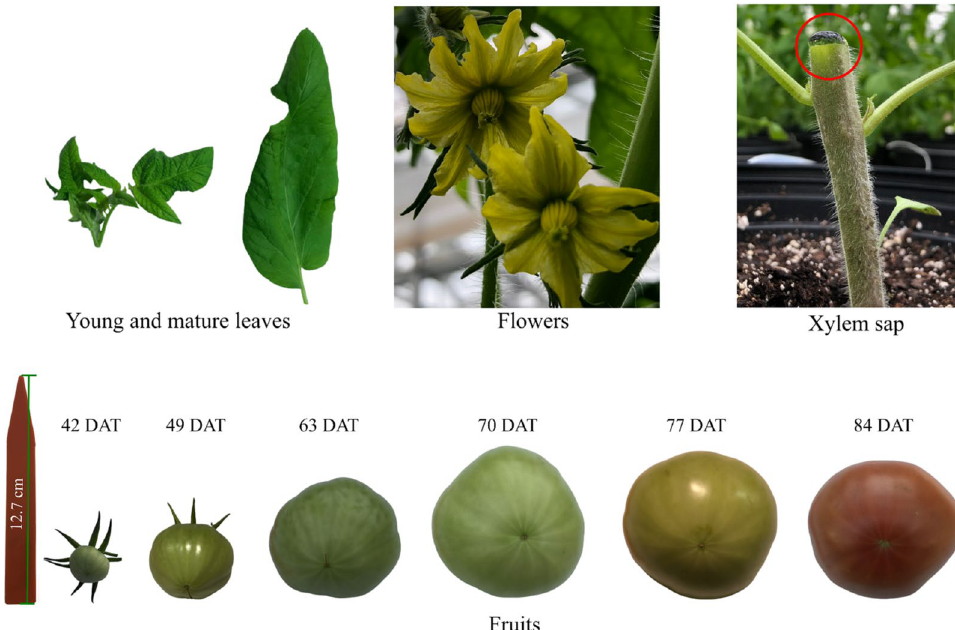
Figure 4. Sampling scheme showing tomato young and mature leaves, flowers, xylem sap, and fruits at different developmental stages. DAT days after